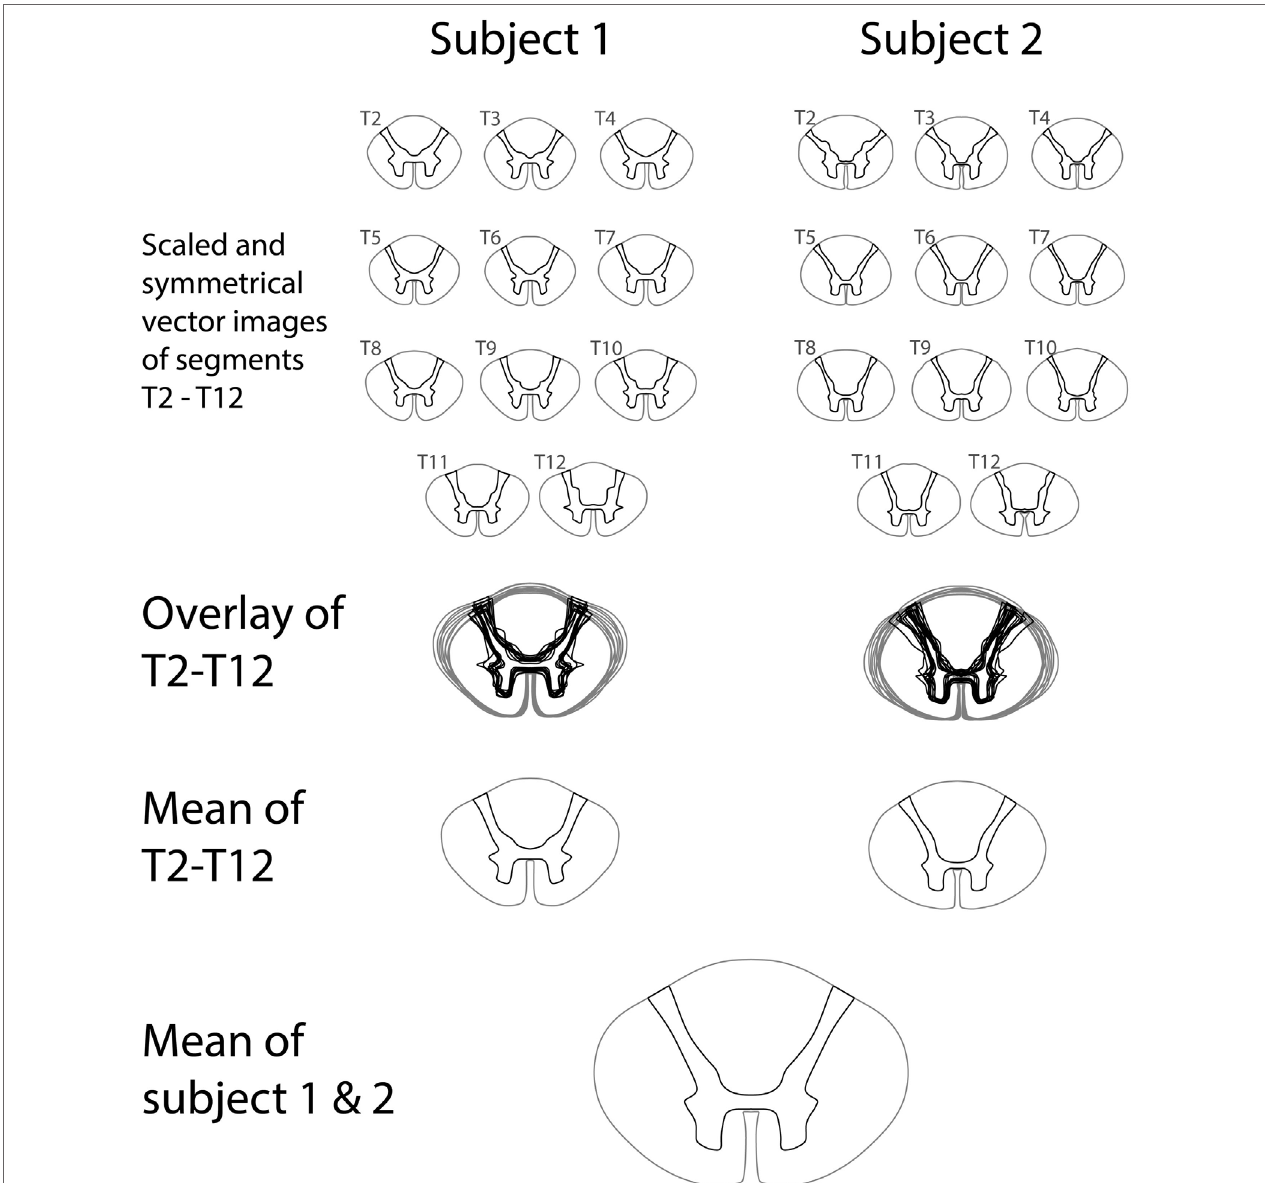
FigUre 4 | Construction of a vector representation of the average thoracic spinal cord shape and white-to-gray matter delineation by averaging segments T2–T12 from two published series of spinal cord